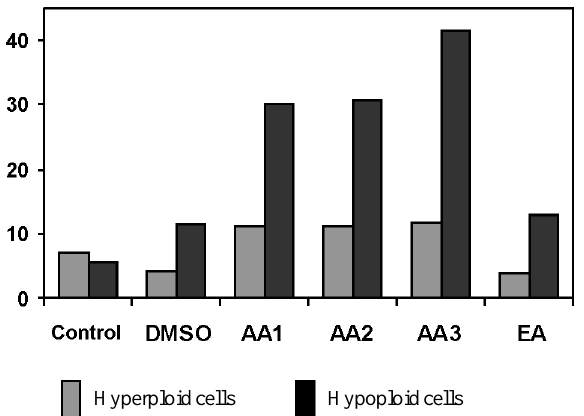
Figure 2 - Frequencies of hyperploid and hypoploid metaphases in CHED cells treated with acetaldehyde doses of 0.002% (AA1), 0.004% (AA2), and 0.006% (AA3) and 1% ethanol